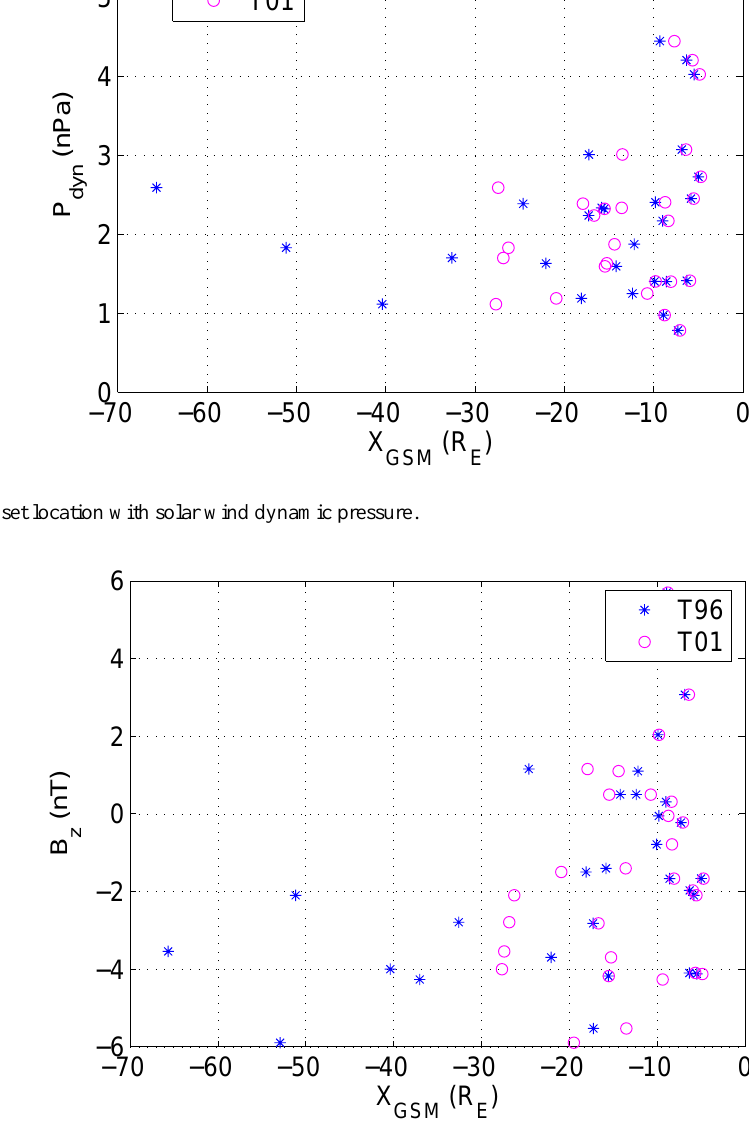
via ground-based magnetometer and photometer data from the CANOPUS array. The various Tsyganenko (1987, 1989, 1996, 2002ab) global magnetic field models were used to map magnetic field lines from the location of the onset arc out to its greatest radial distance in the